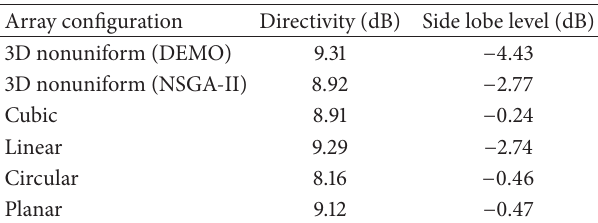
Table 1: Comparison of the performance in terms of the SLL and DIR of 3D nonuniform antenna array with respect to the most conventional arrays for UAVs formation